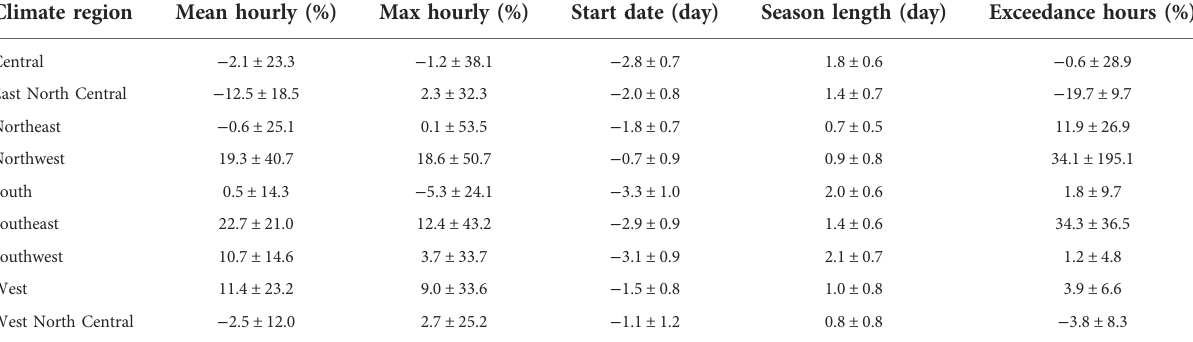
TABLE 2 Regional mean and standard deviation of changes between 2047 and 2004 (August-September) in mean and maximum hourly concentration, start date, season length and exceedance hours for ragweed pollen, estimated using the CMAQ-Pollen model. (mean±standard